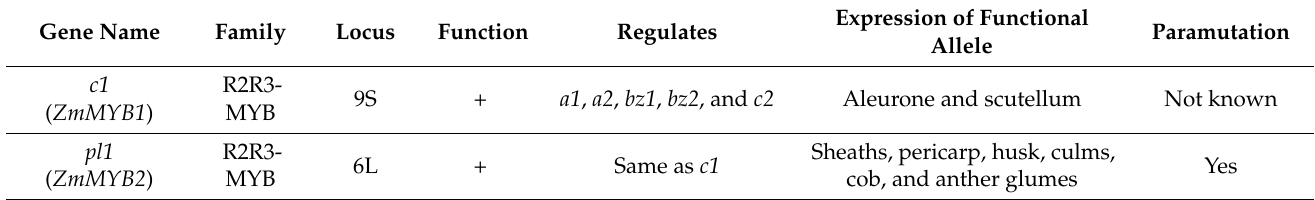
Table 4. Genes that control the anthocyanin accumulation in